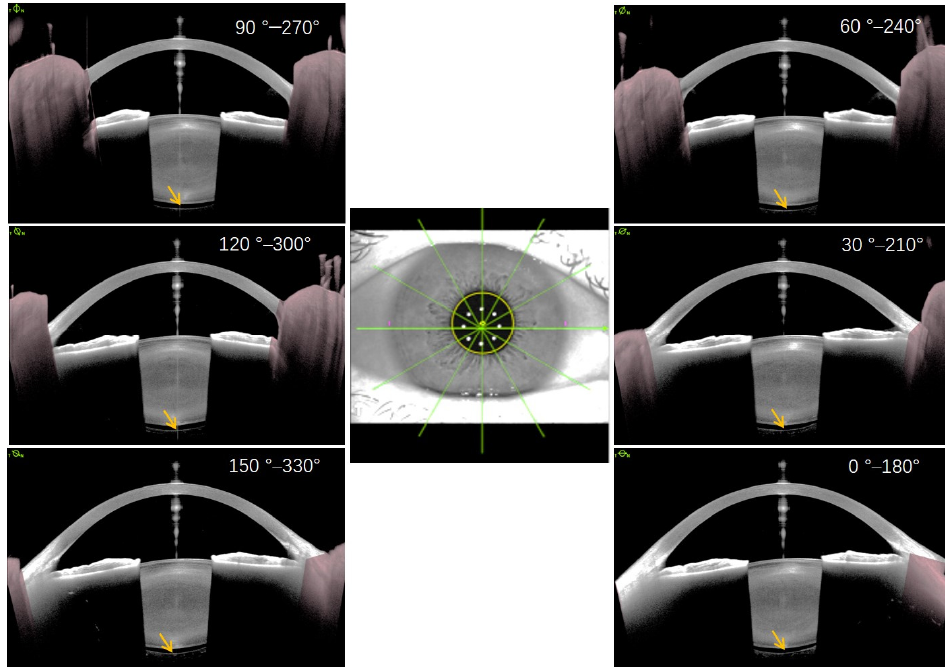
Figure 1. Six high ‐ resolution, cross ‐ sectional anterior segment images with 30° intervals centered on the corneal vertex in a 48 ‐ year ‐ old myopic cataract patient with an axial length of 28.70 mm. Yellow arrows indicate Berger’s space with a natural lens. Of note, the size of Berger’s space in all directions is relatively symmetrical and uniform (around 254 μ m).